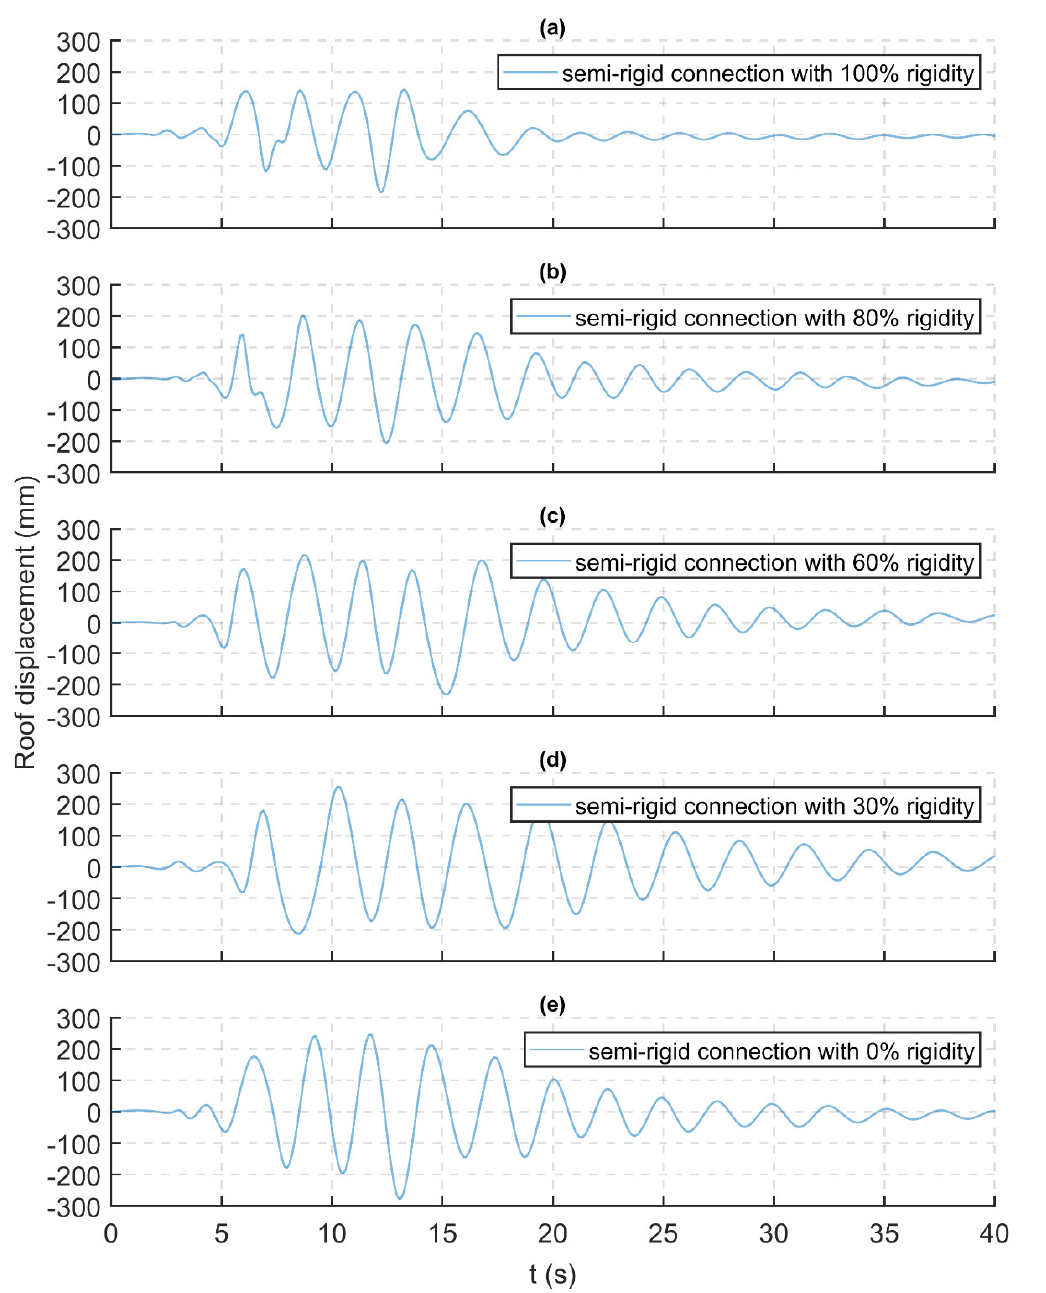
Figure 16. Time–history of roof displacement for 15-story frames with 200 mm SPSW holes exposed to the Northridge earthquake: ( a ) 100% rigidity; ( b ) 80% rigidity; ( c ) 60% rigidity; ( d ) 30% rigidity; and ( e ) 0% rigidity.